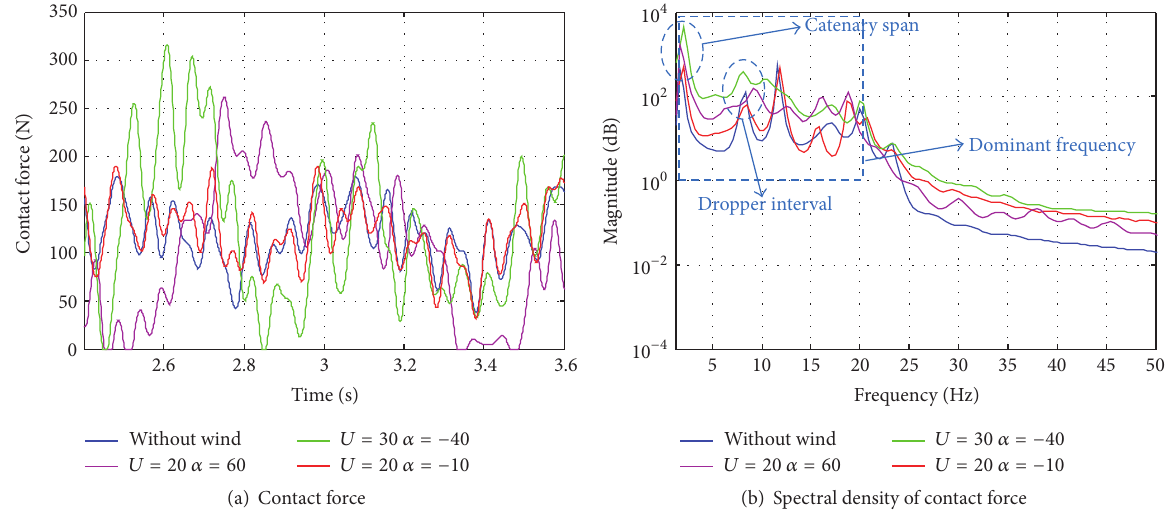
Figure 8: Contact force and its spectral